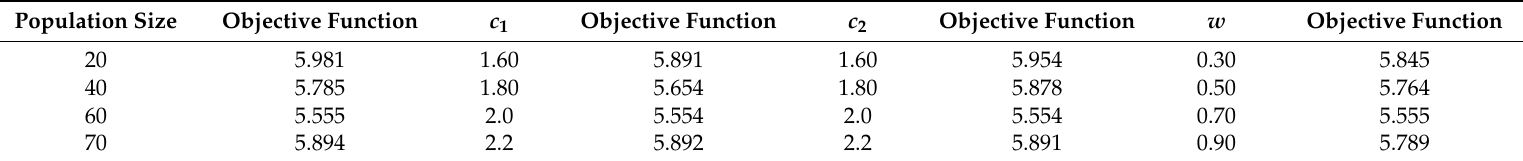
Table 2. Sensitivity analysis for PSO.